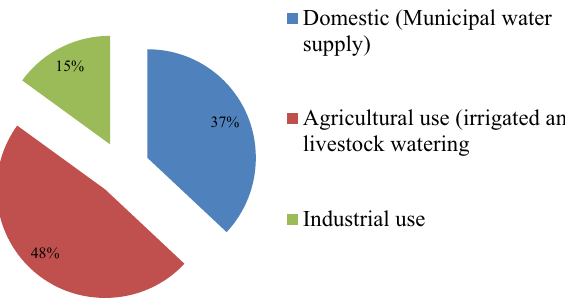
Fig. 2 Distribution of consumptive or ex situ use of freshwater